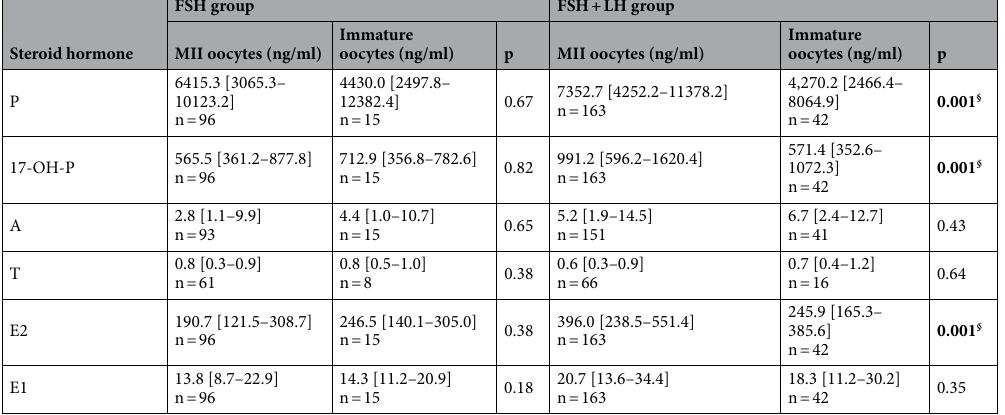
Table 4. Median values [IQR] of Progesterone (P), 17α-Hydroxyprogesterone (17-OH-P), Androstenedione (A), Testosterone (T), Estradiol (E2) and Estrone (E1) levels in FF in the two groups based on oocyte maturity: MII (mature oocytes) and immature oocytes (MI and VG). Data were distinguished between the two groups of ovarian stimulation (FSH and FSH + LH). p columns indicate the statistical significance between the two groups of mature and immature oocytes. In bold statistically significant differences. § Statistical significance was maintained after adjustment for female